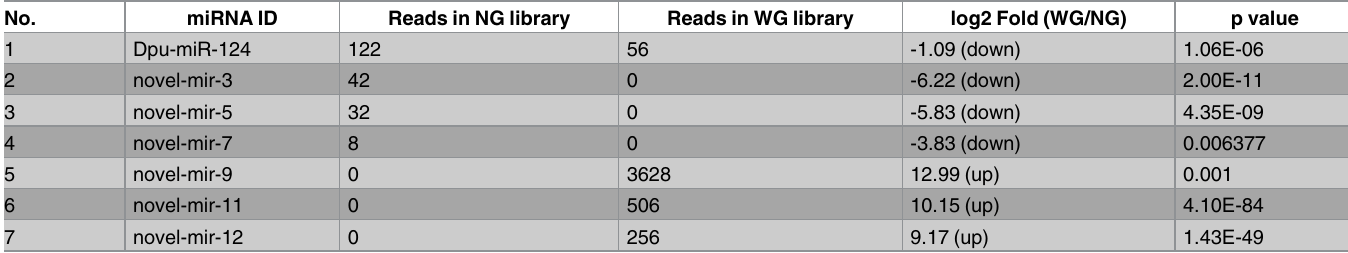
Table 3. Differential expression analysis for miRNAs between NG and WG libraries.